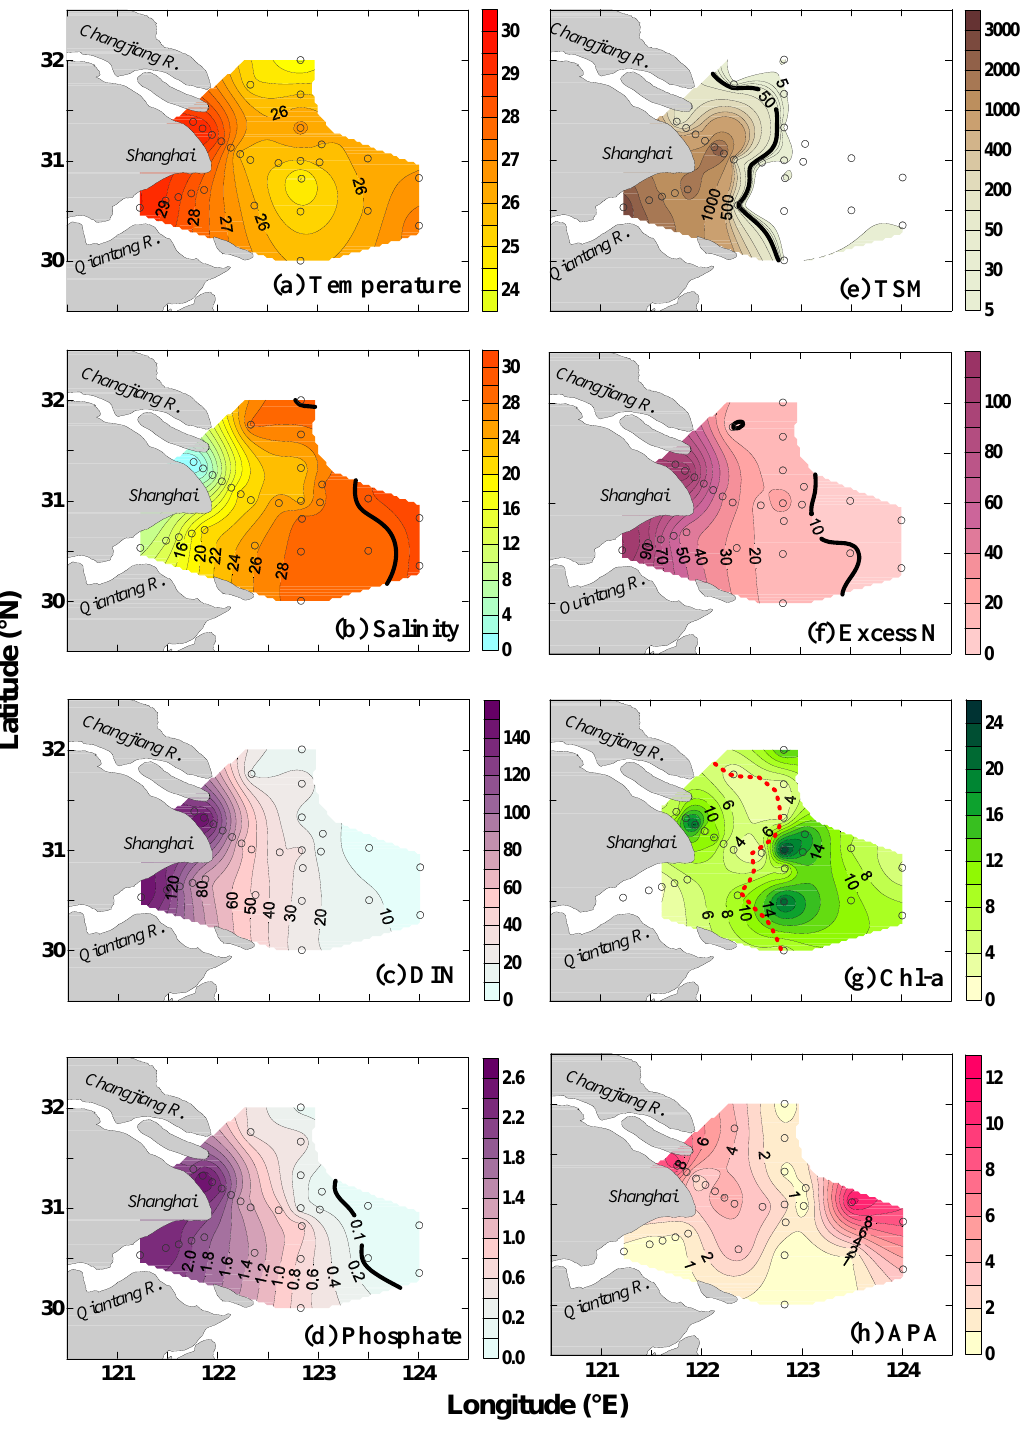
Fig. 2. Spatial distributions of surface (3m) parameters of the CJ plume. (a) Temperature ( ◦ C), (b) salinity, (c) DIN (µM), (d) phosphate (µM), (e) TSM (mgL − 1 ), (f) excess N, (g) Chl a (mgChlm − 3 ), and (h) APA (nMh − 1 ). The red dashed curve stands for TSM isoline of 50mgL − 1